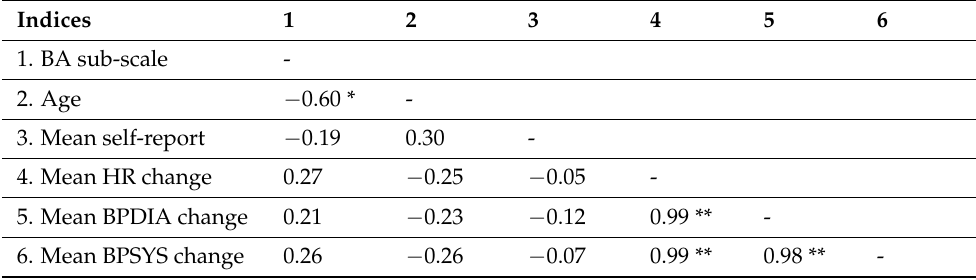
Table 4. Pearson correlations and significance of the variables of Experiment